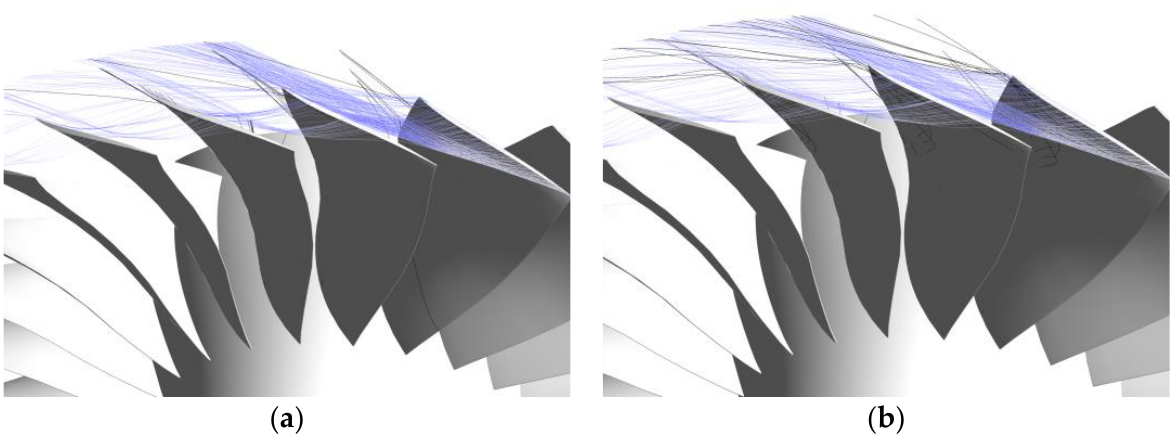
Figure 26. Comparison of TIF structures under different operating conditions. ( a ) DIS case; ( b ) COUP case.